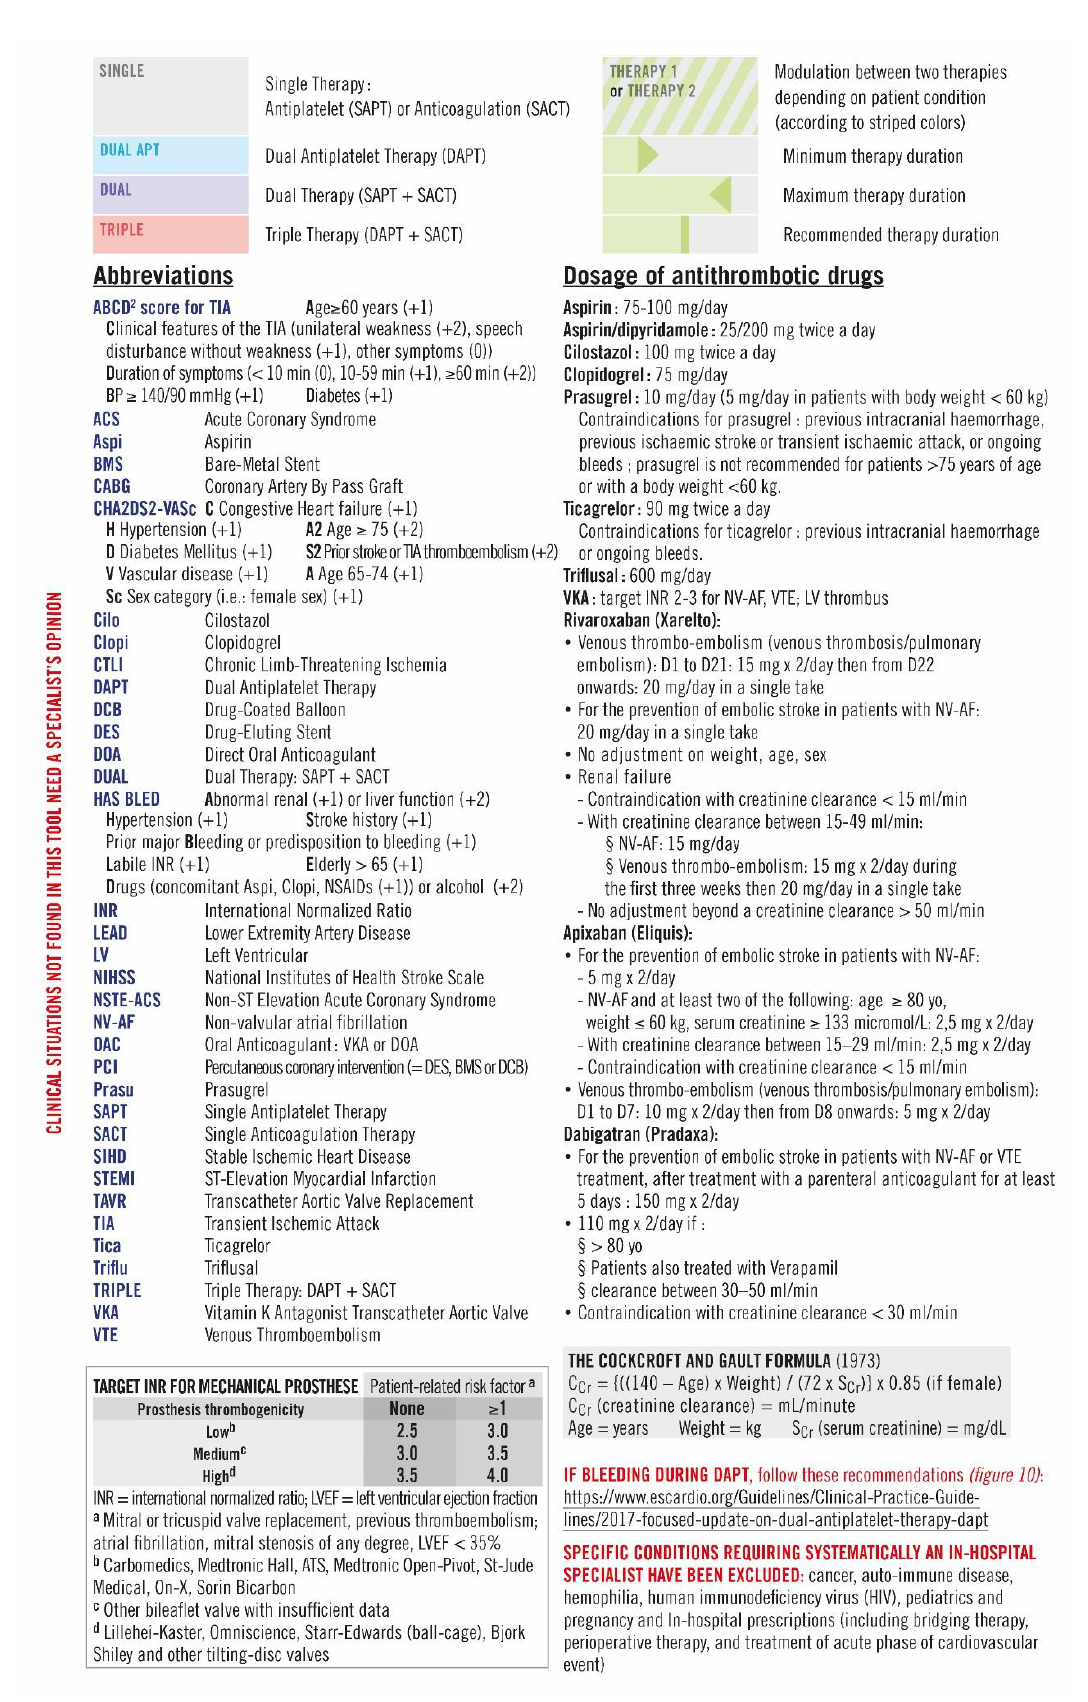
Figure 1. The 2019 synthesis of recommendations for the chronic management of antithrombotic Figure 1. combinations.